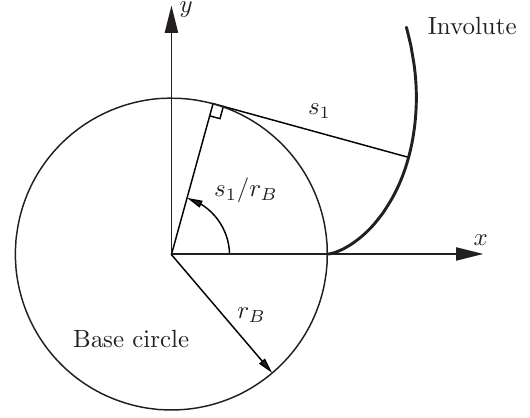
Figure 2: Base circle and involute geometry, the angle is defined by the base circle arc length s 1 .